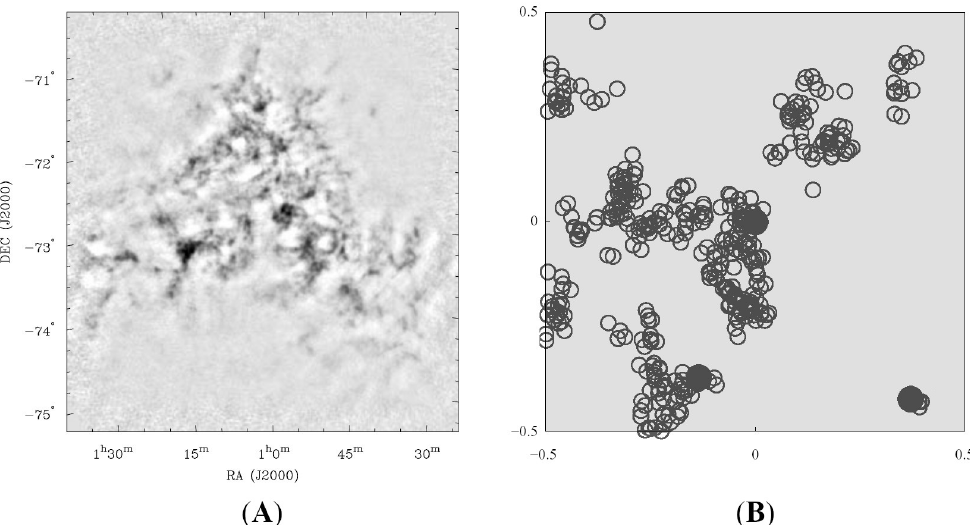
Figure 7. ( A ) is a Hı image of the Small Magellanic Cloud ([38] Figure 1). Adapted with permissions from Ref. [38]. Copyright 1999 Oxford Journals. ( B ) is the pattern, by Monte Carlo simulations, with the UZ ansatz for parameters α = 1.5, n = 700, r 0 = 0.012599. Full circles are the seed node positions of the Markov